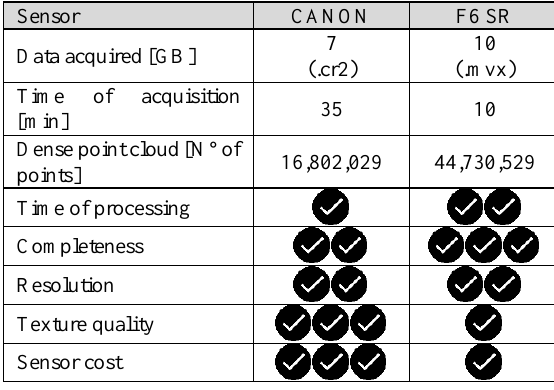
Table 5. Comparison between model obtained by Canon and by F6